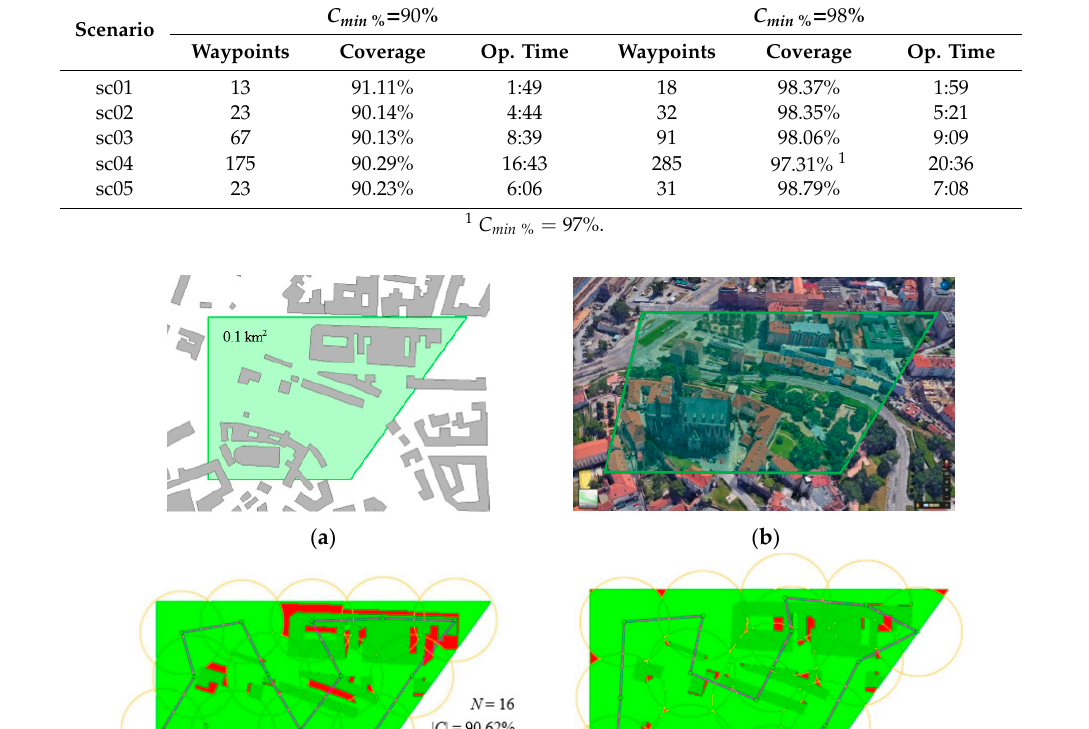
Table 4. Optimization of the number of waypoints.